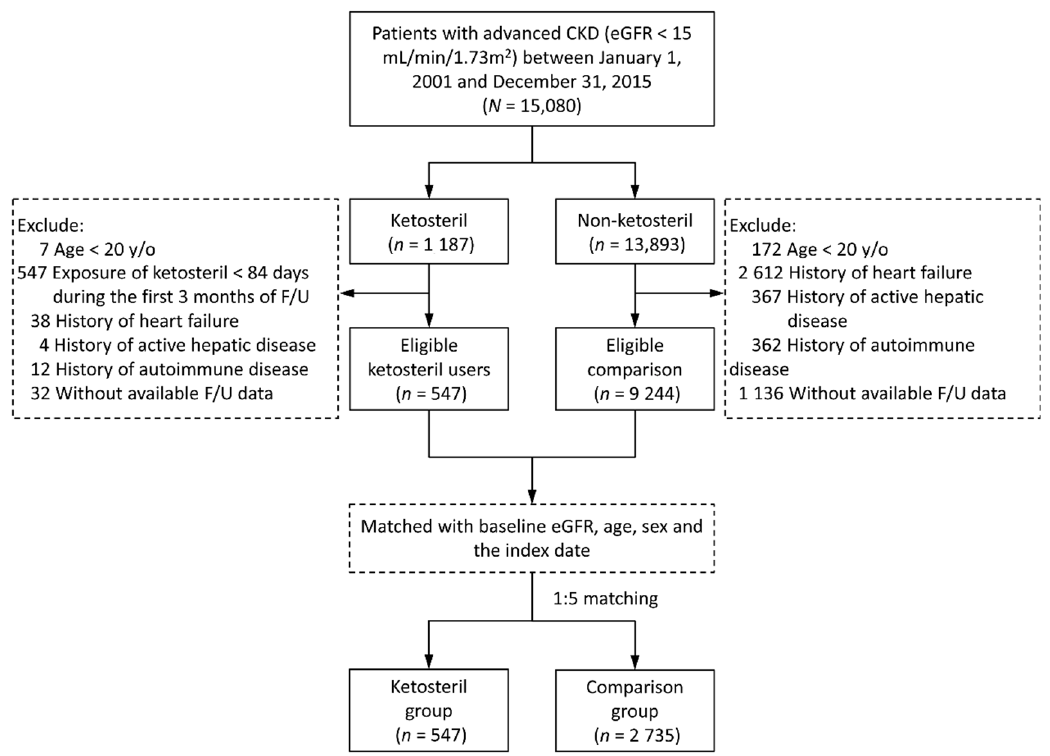
Figure 1. Flowchart for the process of inclusion and exclusion of study patients. CKD, chronic kidney disease; eGFR, estimated glomerular filtration rate; F/U, follow up; y/o, years old.